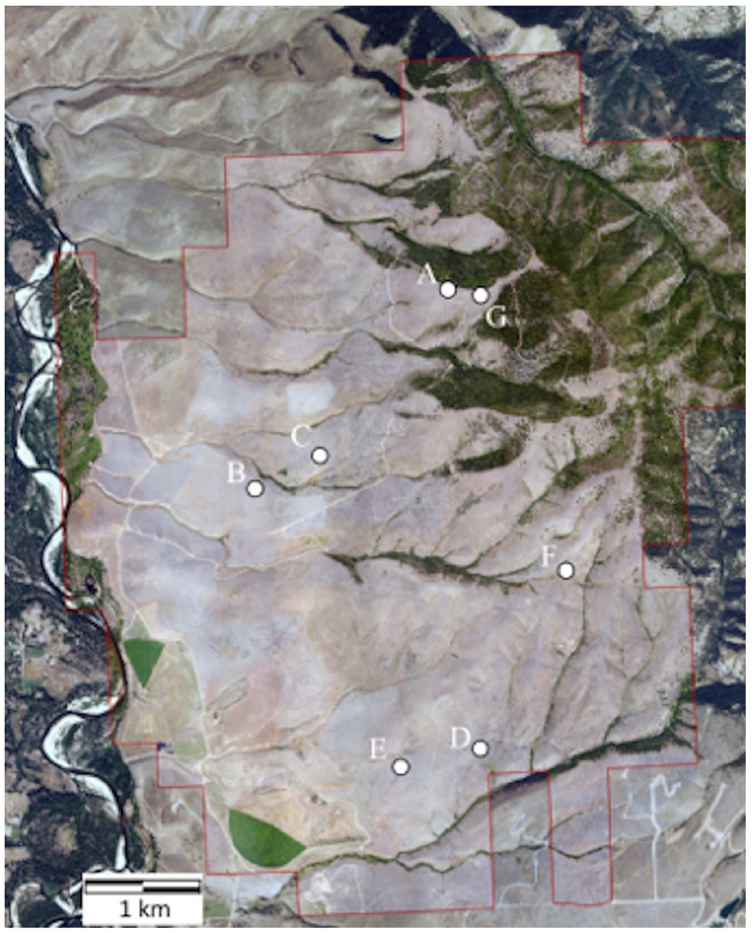
Fig 1. Local Poa secunda collection sites. Poa secunda collectionsites are indicatedby white dots and letters. Approximately 20 plants were collectedfrom each site. The red line outlines the boundary of MPG